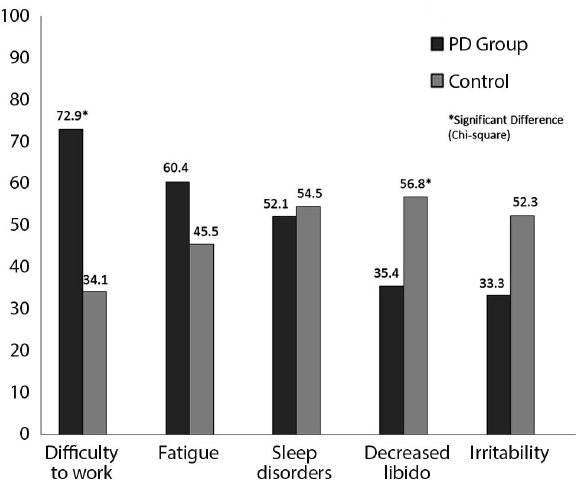
Figure 1. Frequency of depressive